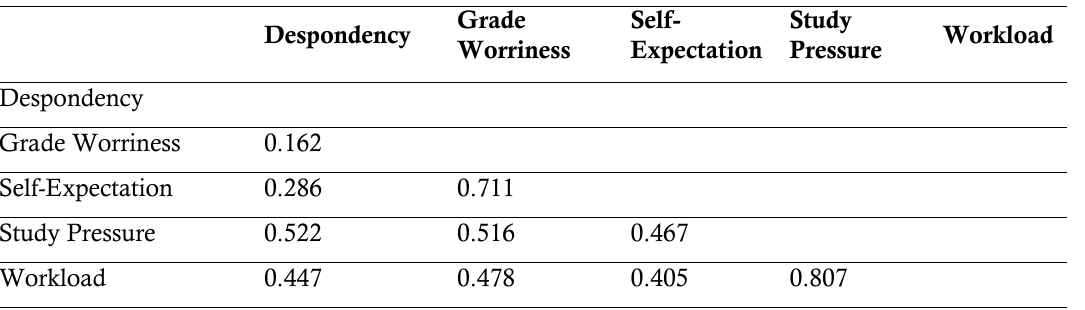
Table 2. The Heterotrait-Monotrait Ratio (HTMT)